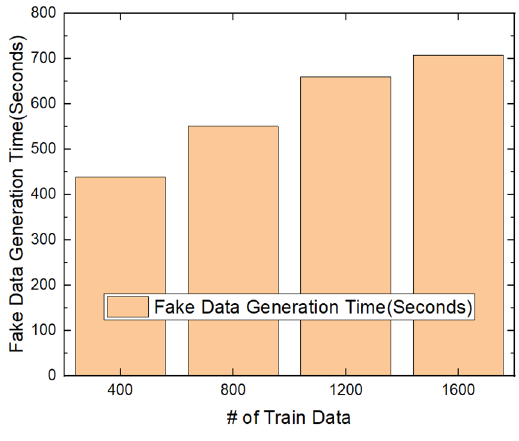
Figure 8. Fake PowerShell Data Generation Time.